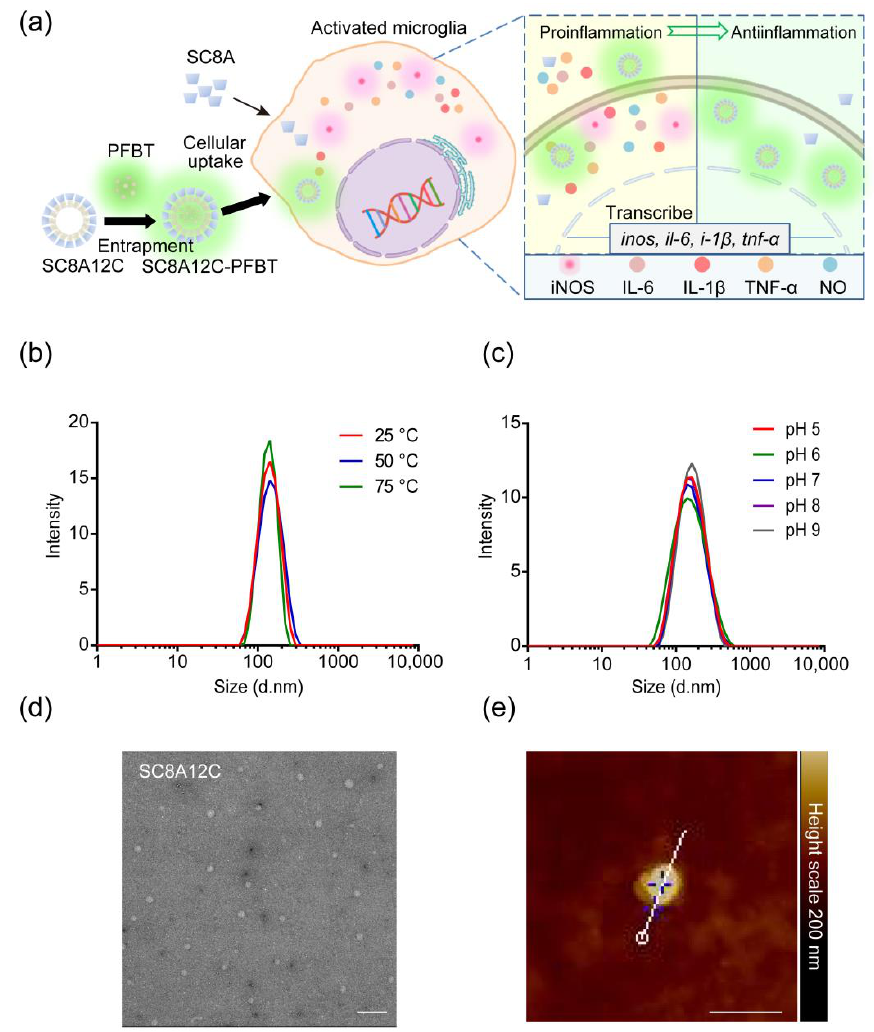
Figure 2. ( a ) Schematic diagram of SC8A or SC8A12C assemblies for inflammatory treatment. SC8A or SC8A12C-PFBT entered microglia to inhibit the expression of iNOS and the release of inflammatory mediators; ( b ) effect of temperature on the size of SC8A12C assemblies (25 µ g/mL) in water; ( c ) effect of pH on the size of SC8A12C assemblies (25 µ g/mL) in water; ( d ) TEM image of SC8A12C assemblies. Scale bar, 500 nm; ( e ) AFM image of SC8A12C assemblies. Scale bar, 500 nm.